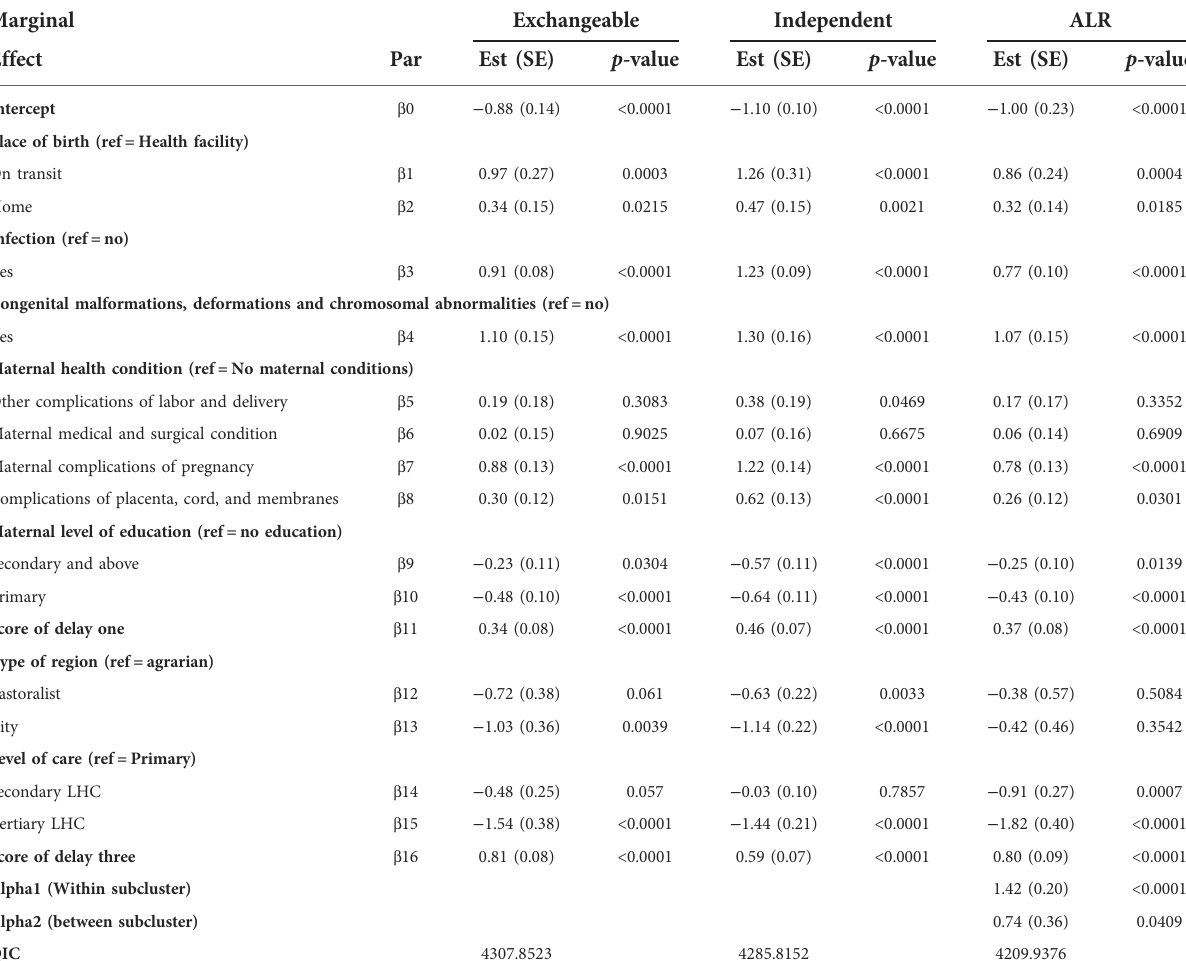
TABLE 7 Parameter estimates and empirical standard errors of GEE and ALR models for